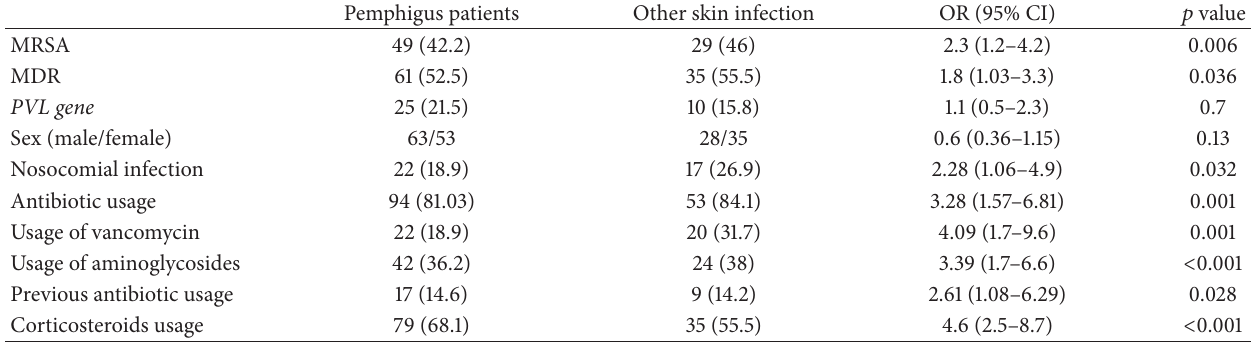
Table 2: Factors associated with S. aureus skin and soft tissue infections in pemphigus patients and other skin